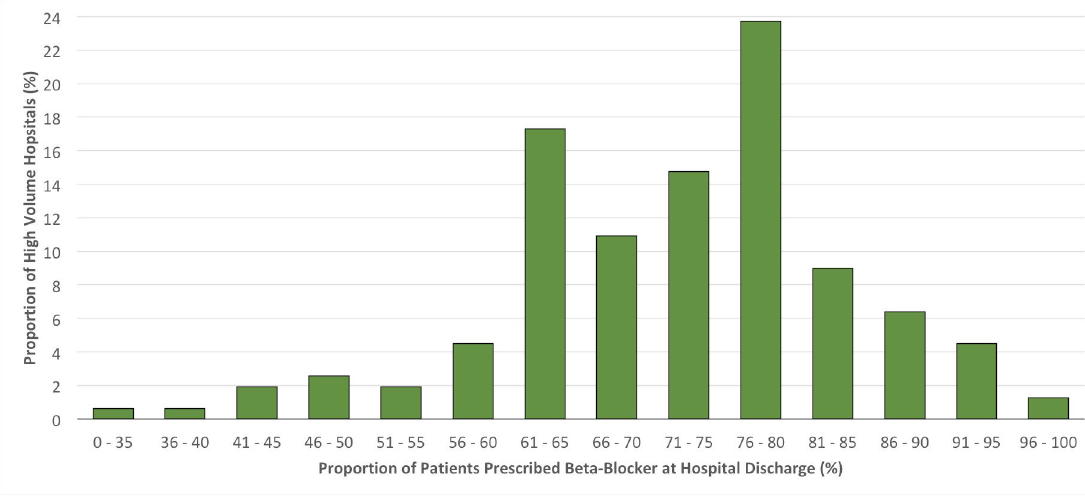
Fig 2. Frequency distribution of the proportions of patients without common indications for BB and/or ACEI/ARB (LVEF < 40%, eGFR � 60 mL/min, diabetes mellitus) who were prescribed BB at hospital discharge � . � Data from hospitals with � 20 discharges with MINOCA during the study